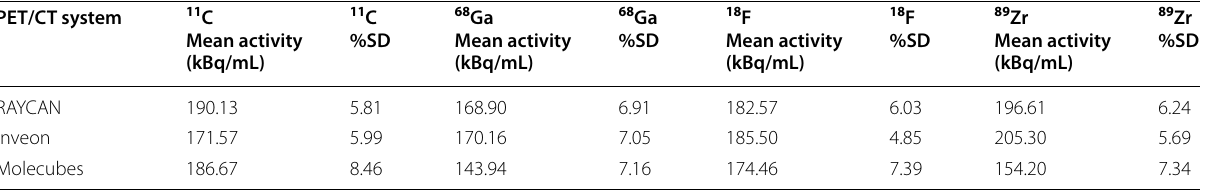
Table 6 The mean activity (kBq/mL) and the percentage standard deviation (%SD) measured from the uniform compartment of the phantom PET/CT system